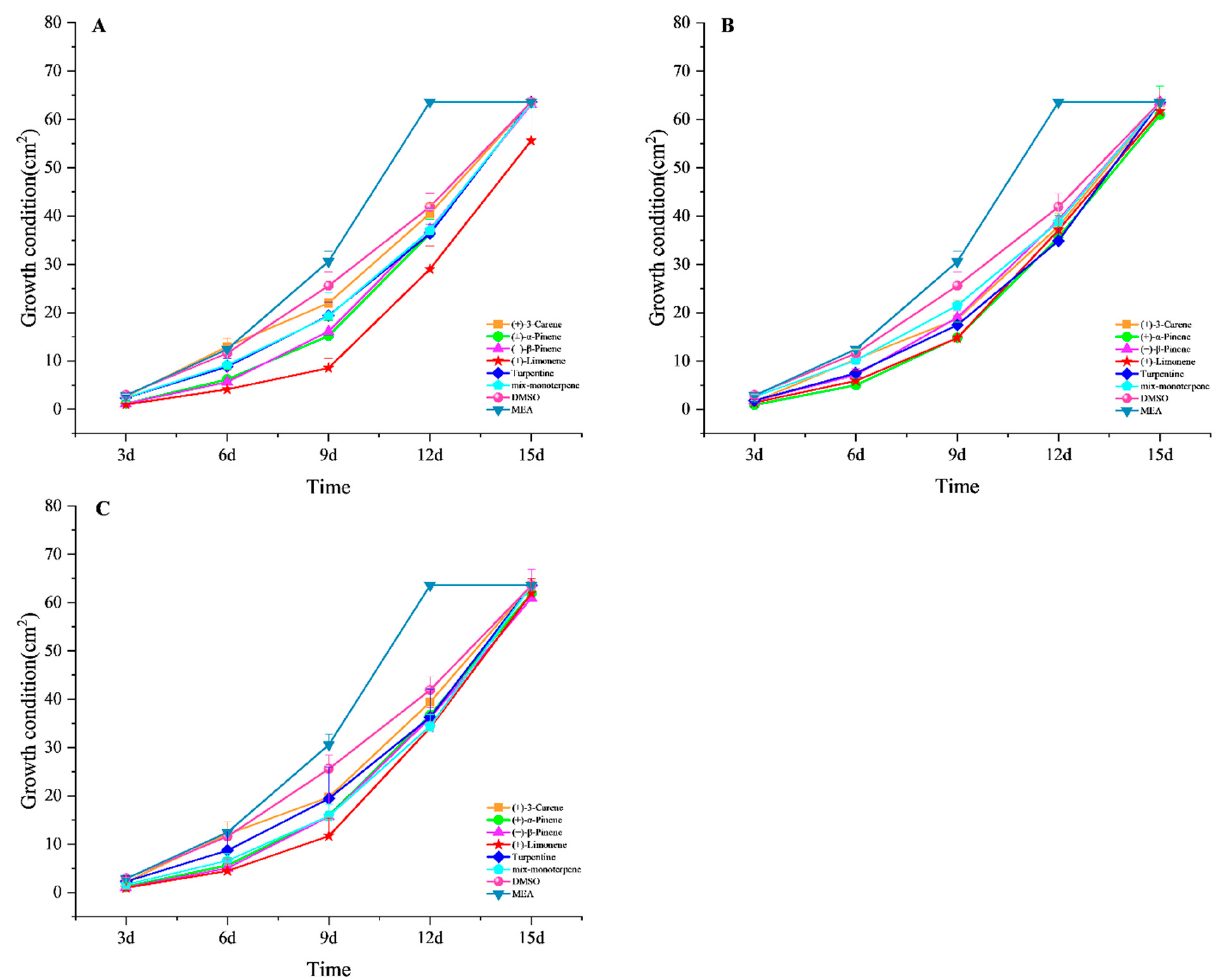
Figure 3. Growth rate of L. qinlingensis in different terpenoid treatments. The growth condition was obtained by calculating the area of the colony. The results represent the mean ± SE of five independent experiments. ( A ) 5% concentration treatments; ( B ) 10% concentration treatments; ( C ) 20% concentration treatments.